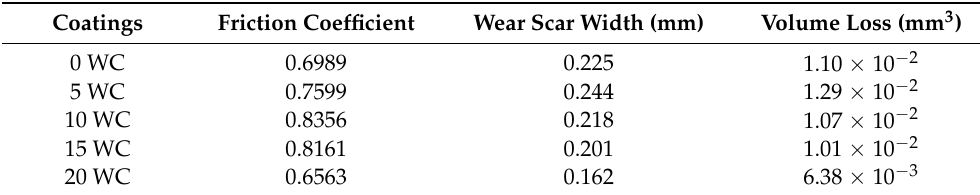
Table 5. Friction coefficient and volume loss of different